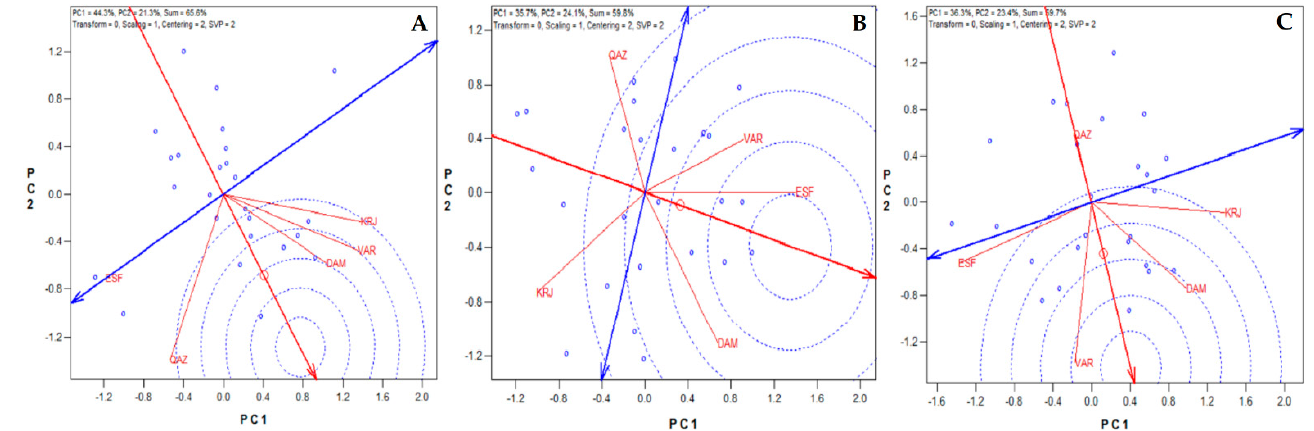
Figure 5. Ranking biplot for comparison of the genotypes with the ideal genotype. ( A ): First year,